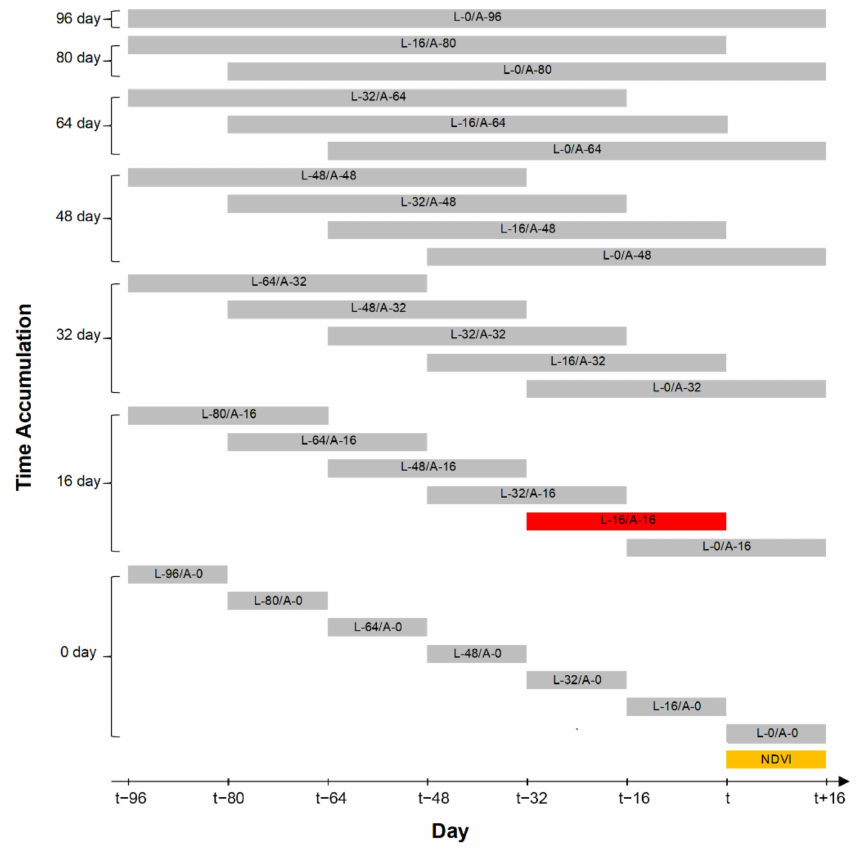
Figure 2. The 28 schemes considering time accumulation and time lag effect in this study. Yellow bar is the time period of NDVI. Grey bars indicated the time periods used to calculate the sum value of climate time series in different